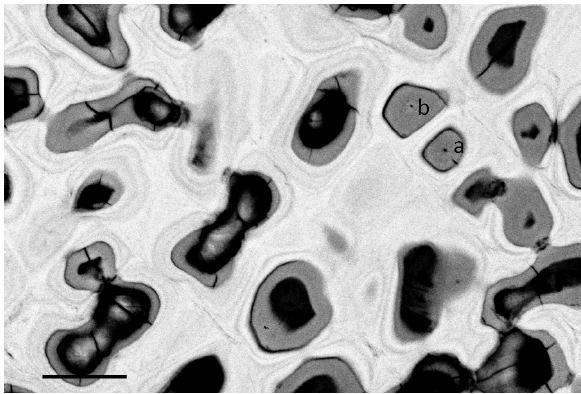
Fig. 4. SEM BSE image of coralline alga section (sample 47) taken with increased contrast to visualize the concentric zonations caused by different compositions of Mg-calcite in the cell wall. Black rep- resents magnesite or void, grey is protodolomite and white to light- grey is Mg-calcite. (a) : protodolomite rim 50.65mol% MgCO 3 (b) : protodolomite rim 55.29mol% MgCO 3 . Black rims around a and b are not void and assumed to be magnesite, but are too narrow for accurate spot analysis. Scale bar = 10µm.